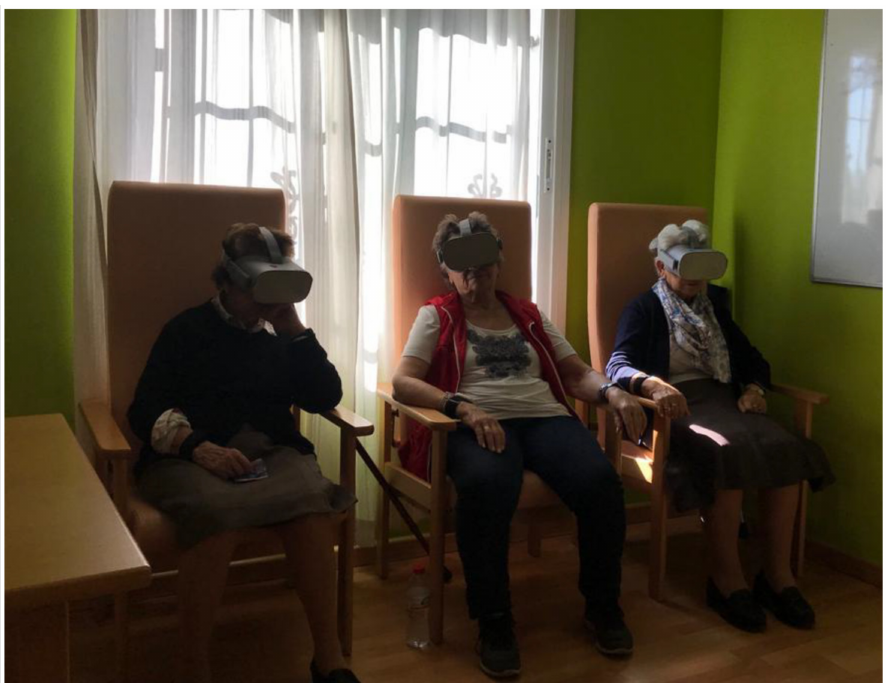
Figure 1. Participants watching the virtual scenes during the